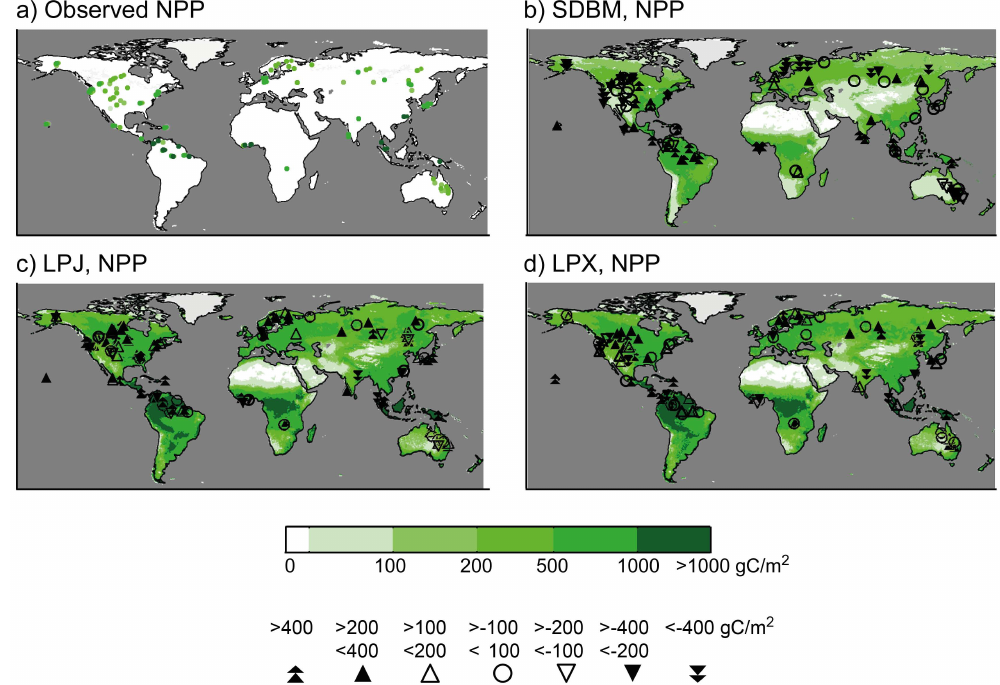
Fig. 9. Comparison of observed and simulated annual average net primary production (NPP). Observed values are from the Luyssaert et al. (2007) and Ecosystem/Model Data Intercomparison datasets (Olson et al., 2001), and the simulated values are from (b) Simple Diagnostic Biosphere Model (SDBM), (c) LPJ and (d) LPX. The symbols in (b) , (c) and (d) indicate the magnitude and direction of disagreement between simulation and observed values, where the upward and downward facing triangles represent over- and undersimulation respectively. Double triangles indicate a difference in NPP of > 400gCm − 2 , single filled triangles a difference between 200 and 400gCm − 2 , single empty triangles a difference 100 and 200gCm − 2 , and empty circles a difference of < 100gCm −